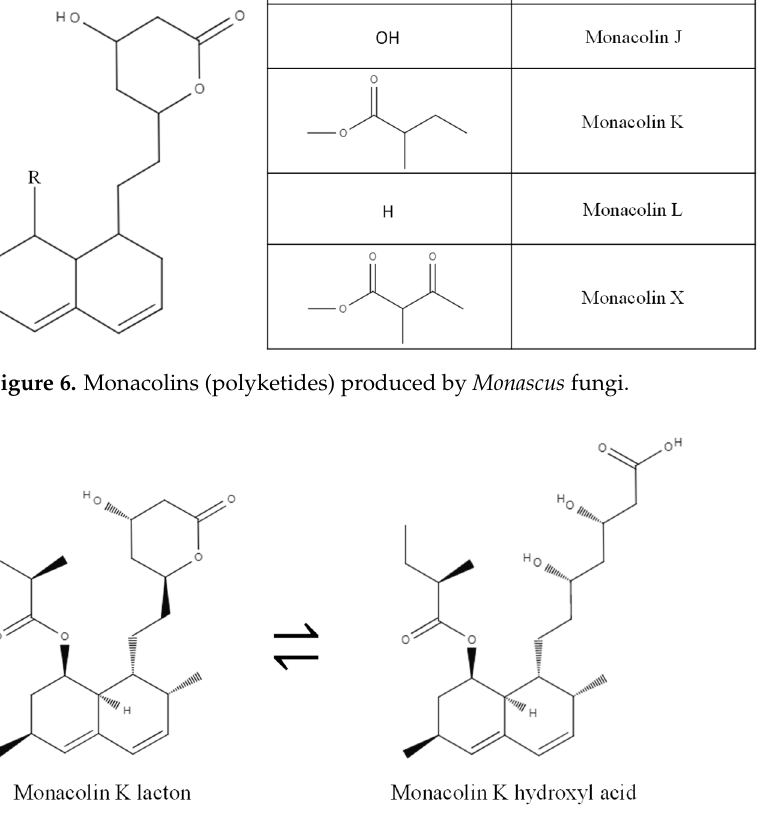
Figure 7. Lactone and acid forms of monacolin K.